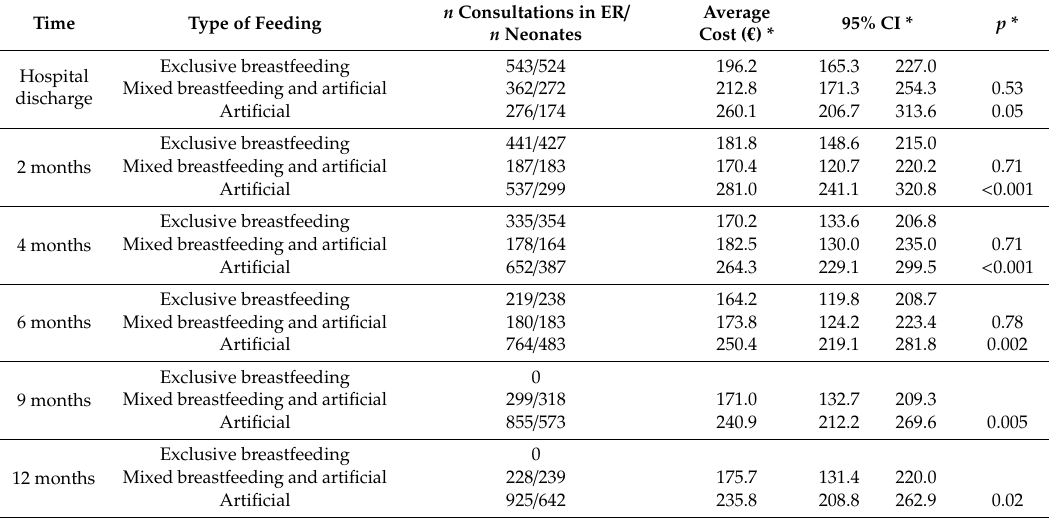
Table 3. Relationship between type of feeding and costs due to consultations in emergency